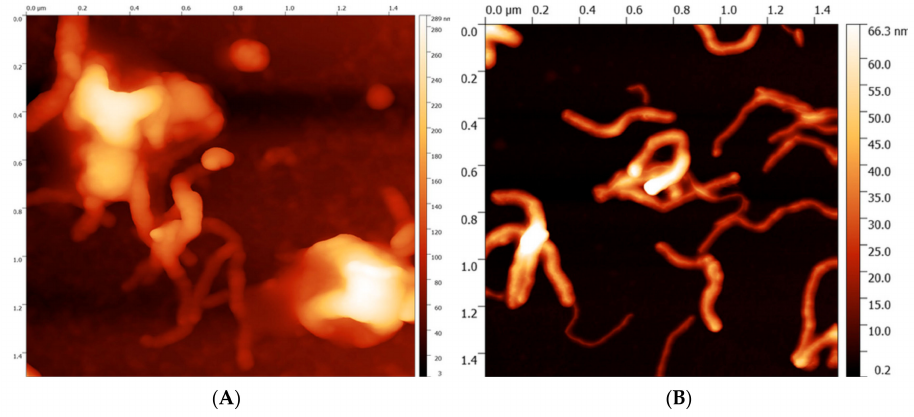
Figure 4. AFM images of ( A ): GCE / MWCNTs / GOx surface. ( B ): GCE /